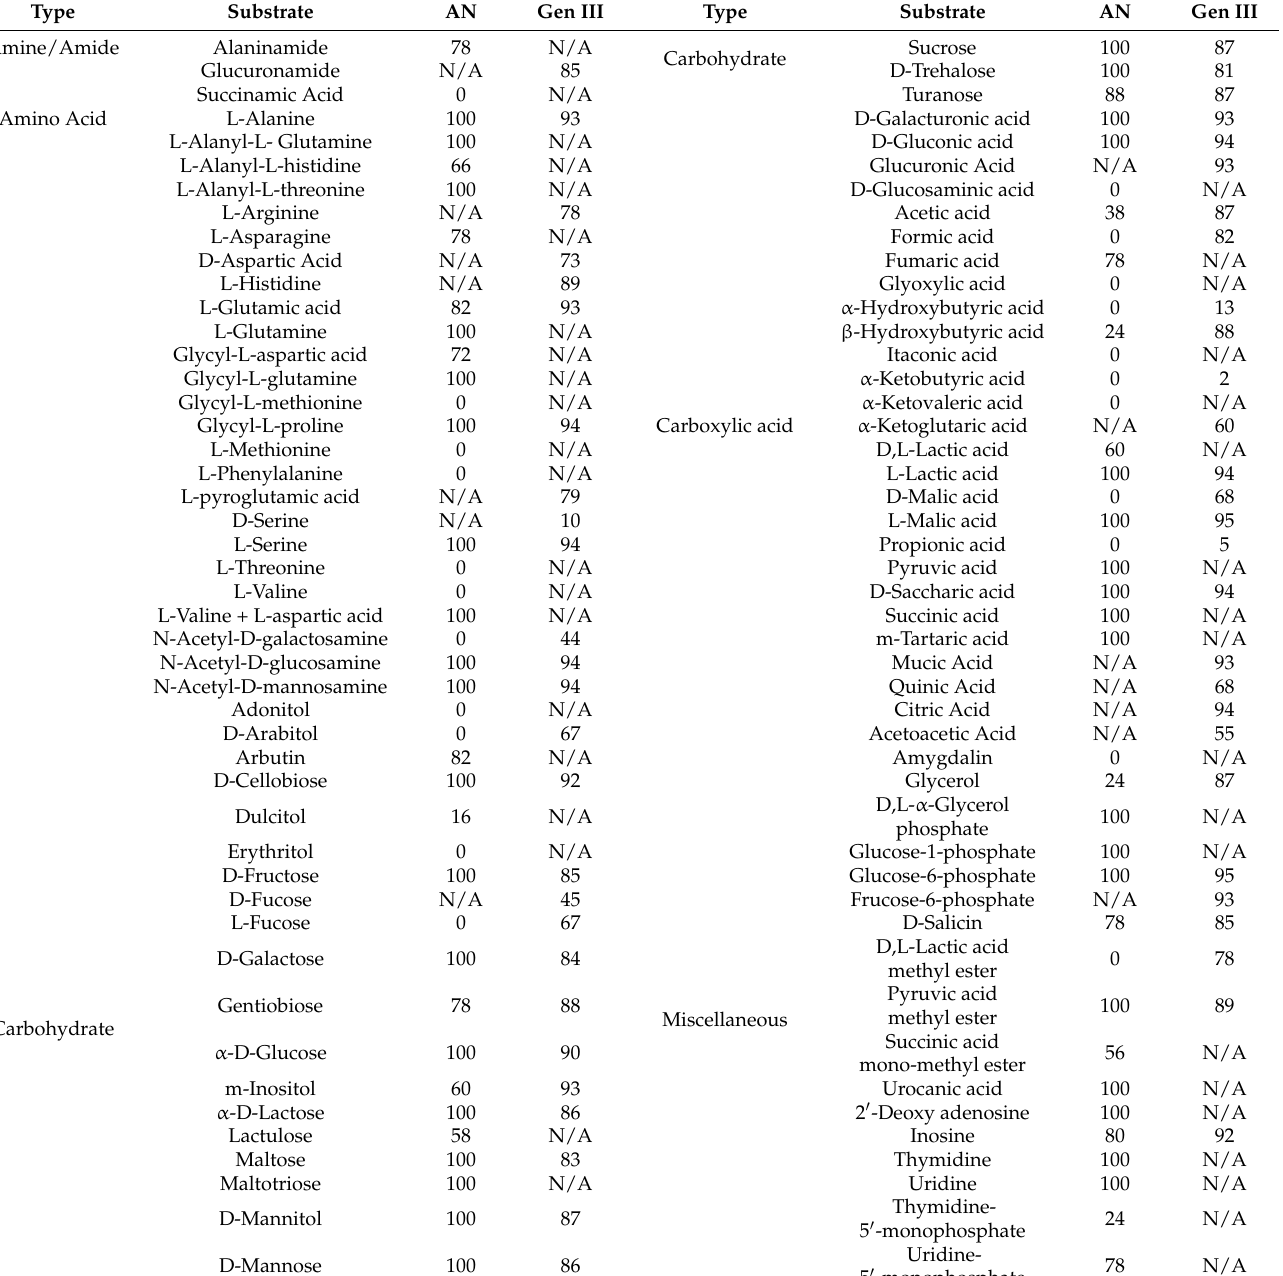
Table 1. Carbon source utilization pattern of isolate KBH 6958 using BIOLOG AN and GEN III